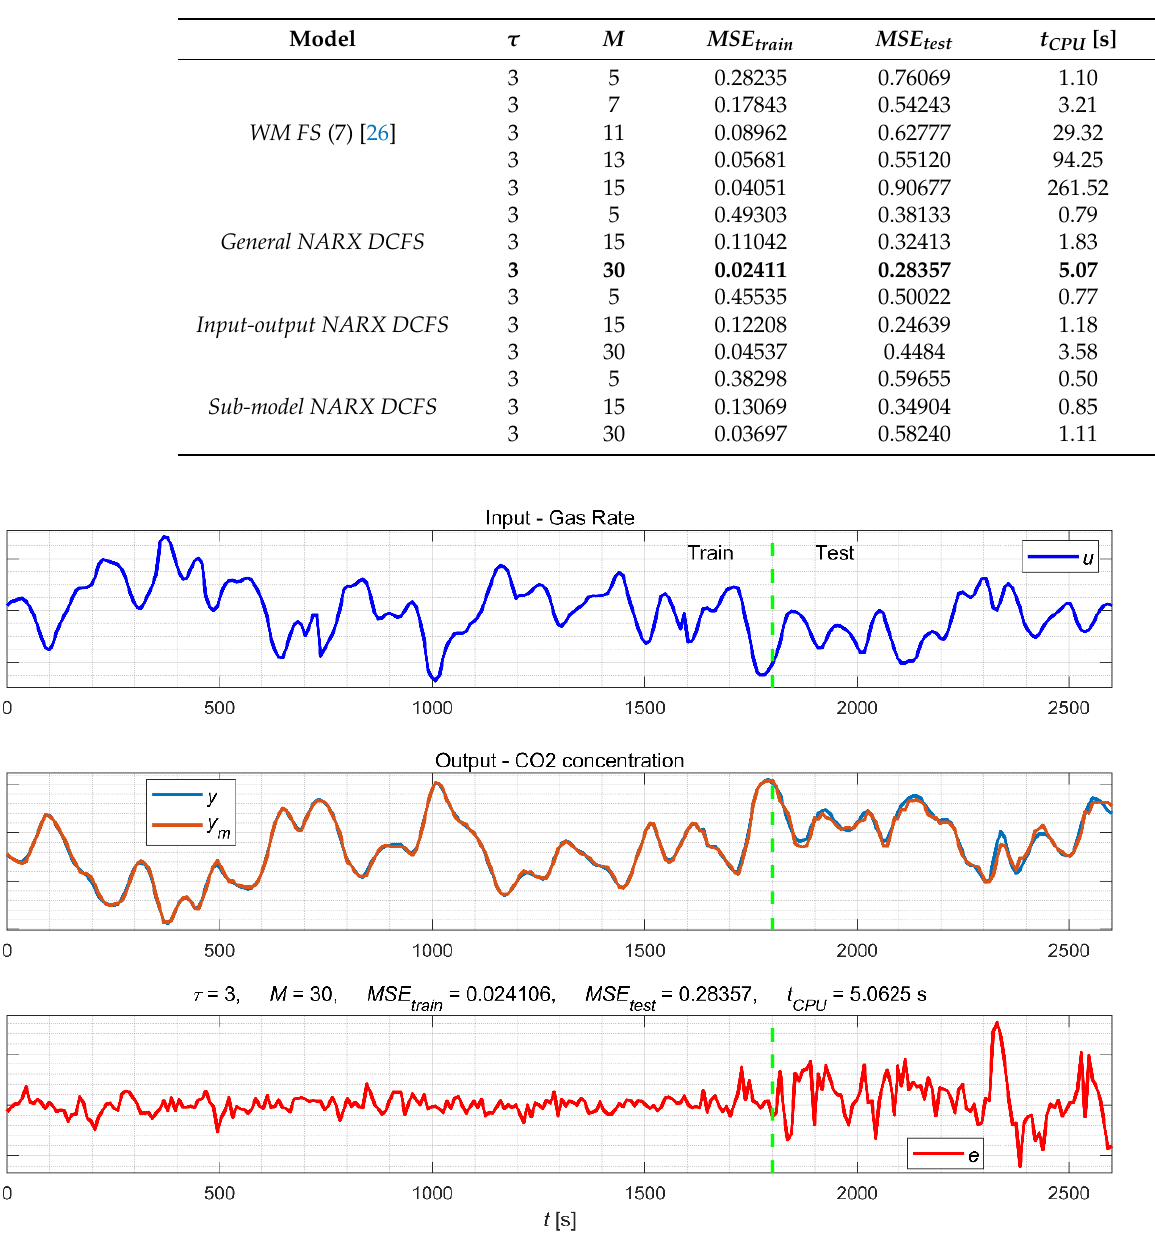
Figure 6. Prediction result of General NARX DCFS model output and original system output for Box and Jenkin’s gas furnace data set: ( a ) input signal—gas rate, ( b ) output comparison, and ( c ) respective error. The green line divides the training data from the test data. Table 3. Identification results for the Box – Jenkins gas furnace.